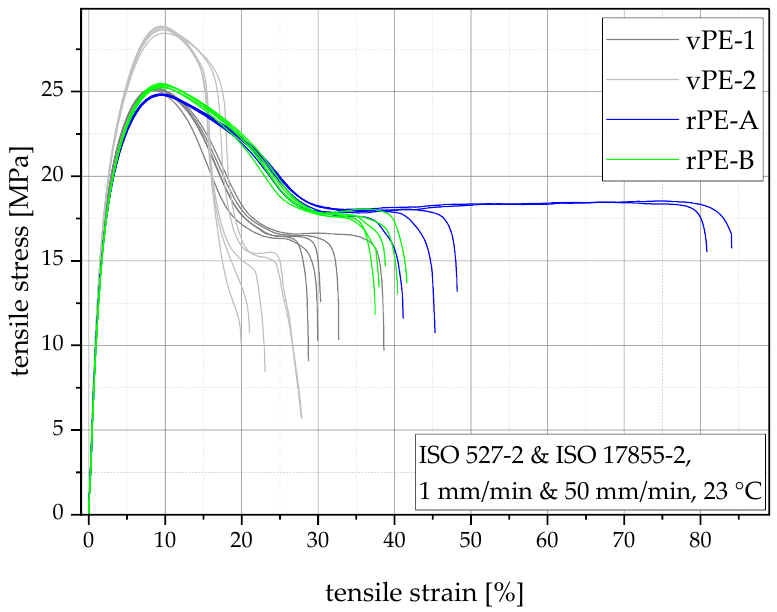
Figure 9. Tensile stress vs. tensile strain diagram showing five measurements of each material. The tensile moduli show a clear distinction between the virgin and recycled PE-HD grades. Both virgin grades show higher tensile moduli (vPE-1 with 977 MPa and vPE-2 with 1020 MPa) than the two recyclates (rPE-A with 939 MPa and rPE-B with 914 MPa).